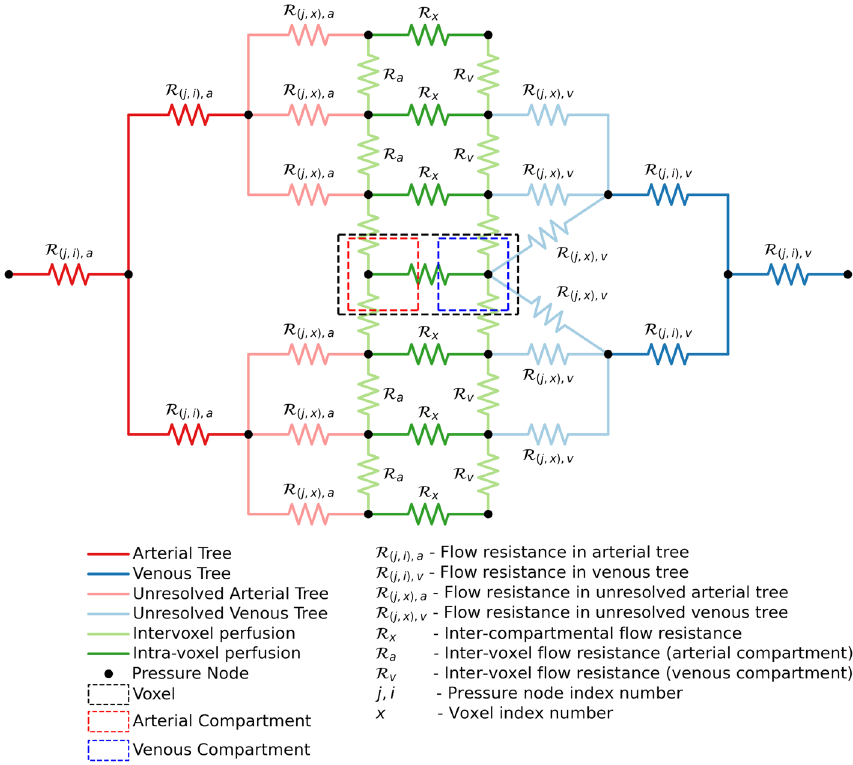
Figure 1. Proposed resistance model of Hodneland et al. 37 . The arterial tree and venous tree is modeled as 1D pipe flow network. The resistance offered by each of these tree elements is calculated using the Hagen–Poiseuille equation (Eq. (1)). Each voxel has two compartments—arterial and venous to represent tissue, capillary bed, and capillary perfusion. The blood perfusion in tissue voxels is 3D. The inter-voxel compartmental flow is modeled using Darcy’s equation (Eq. (2)) and estimation of tissue permeability obtained from the literature. Blood perfusion from arterial compartment to venous compartment in a voxel is calculated using Eq. (3). The unresolved arterial and venous tree represents the Dirac distribution function (Eq. (6)) used to couple 1D flow in resolved network with 3D perfusion in tissue